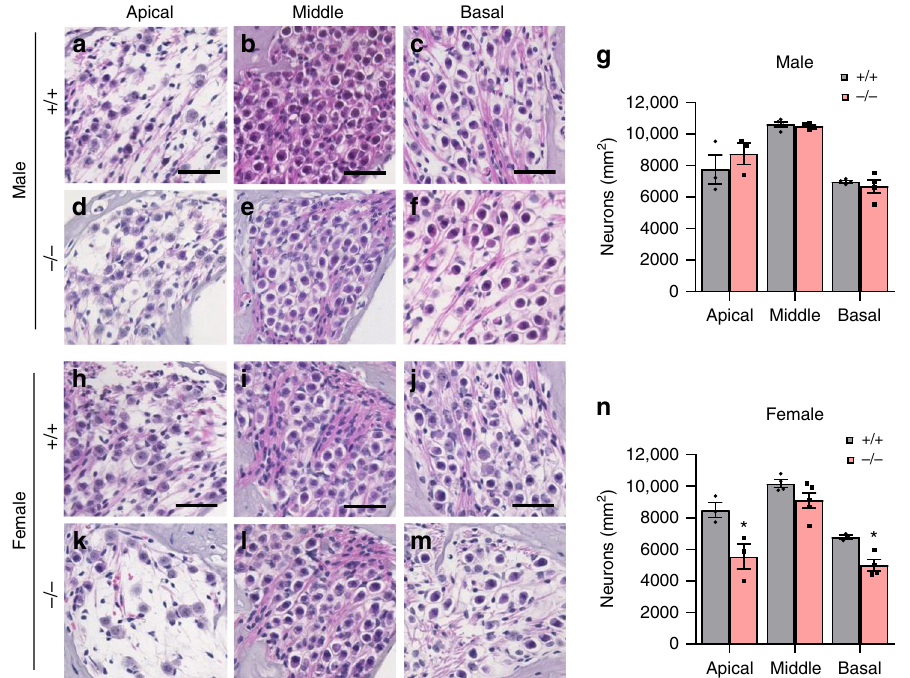
Fig. 3 Assessment of SGN density. a – n SGN regions in the apical, middle, and basal regions of cochlear tissues from male ( a – f ) and female ( h – m ) Gsta4 + / + and Gsta4 − / − mice after cisplatin treatment. Scale bar = 20 μ m. SGN densities in the apical, middle, and basal regions of cochlear tissues from male ( g ) and female ( n ) Gsta4 + / + and Gsta4 − / − mice were counted and quanti fi ed. The quanti fi cation shows a mean of at least three independent experiments ( n = 3), * p < 0.05 vs. + / + (two-way ANOVA). Error bars represent ± s.e.m. Source data are provided as a Source Data fi